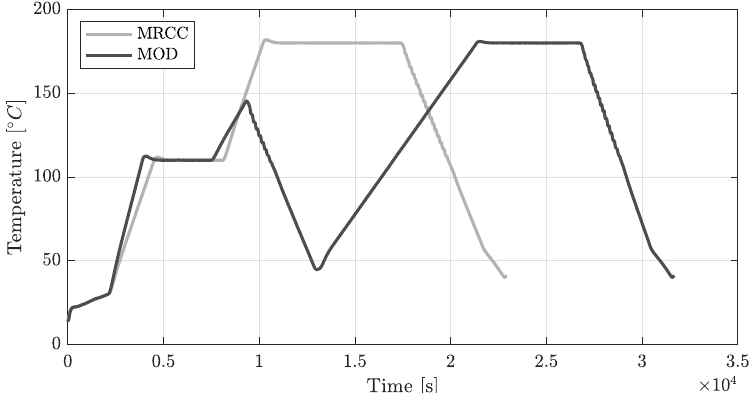
Figure 2. Two different temperature profiles during autoclave cure for the two considered manufac- turing processes MRCC and MOD.